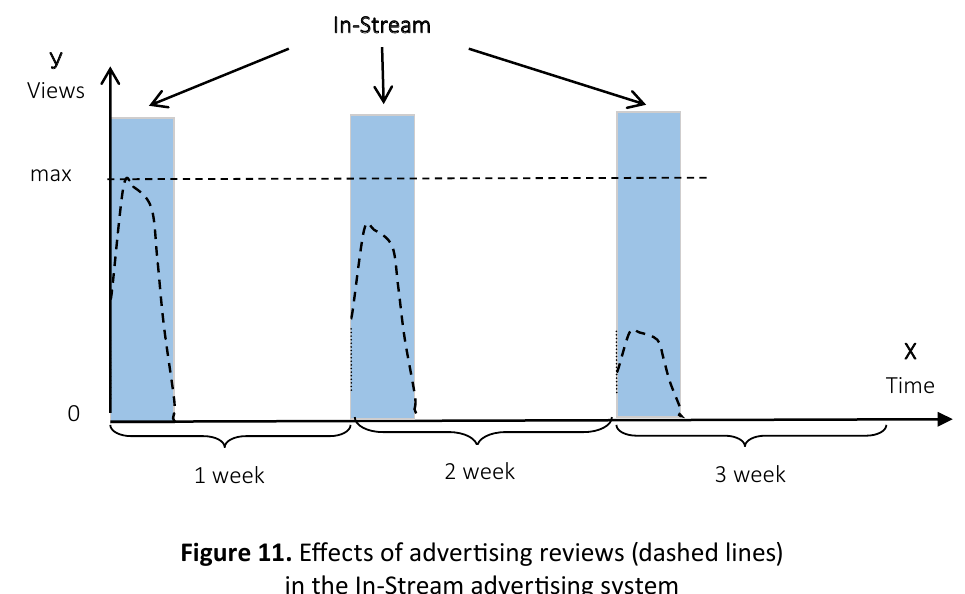
Figure 11. Effects of advertising reviews (dashed lines) in the In-Stream advertising system